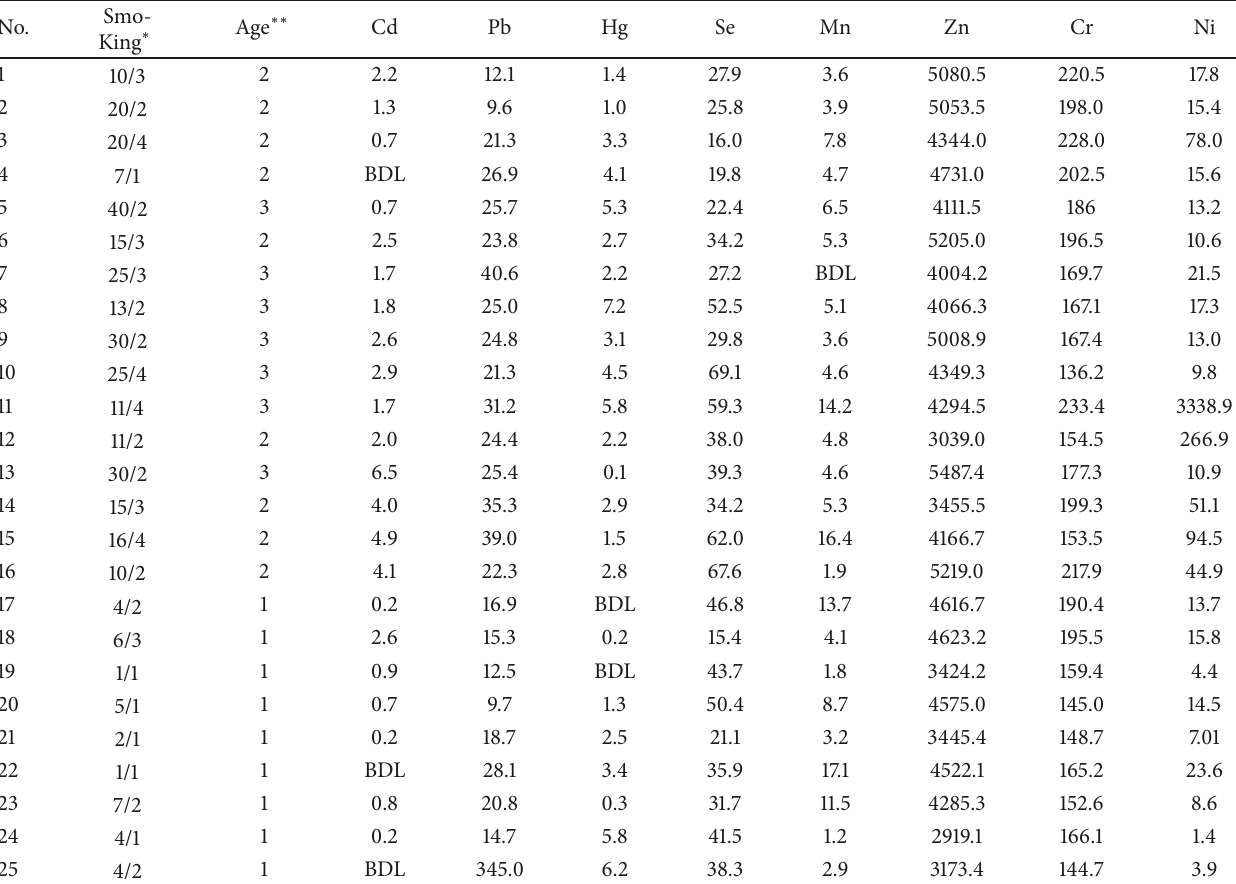
Table 3: Toxic elements levels in cigarettes smokers human blood ( 𝜇